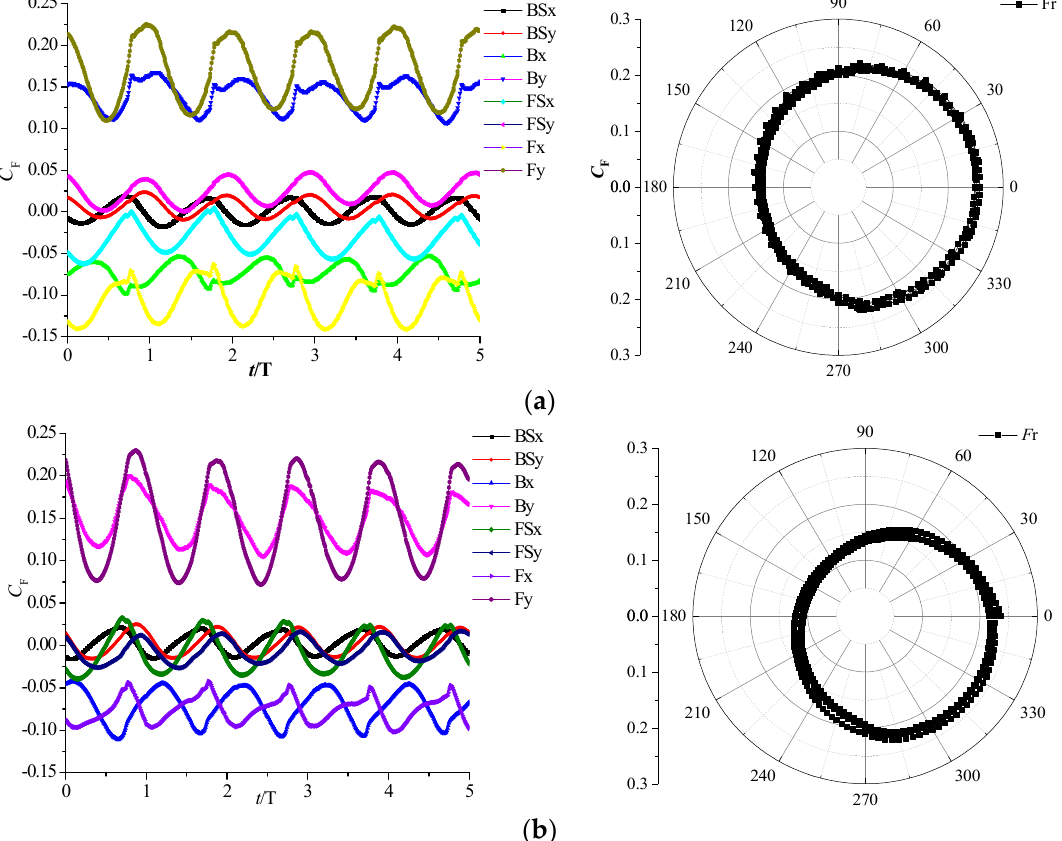
Figure 10. The Radial Force on the Impeller at 1.0 Q d . ( a ) non-eccentricity; ( b ) impeller eccentricity (2, −